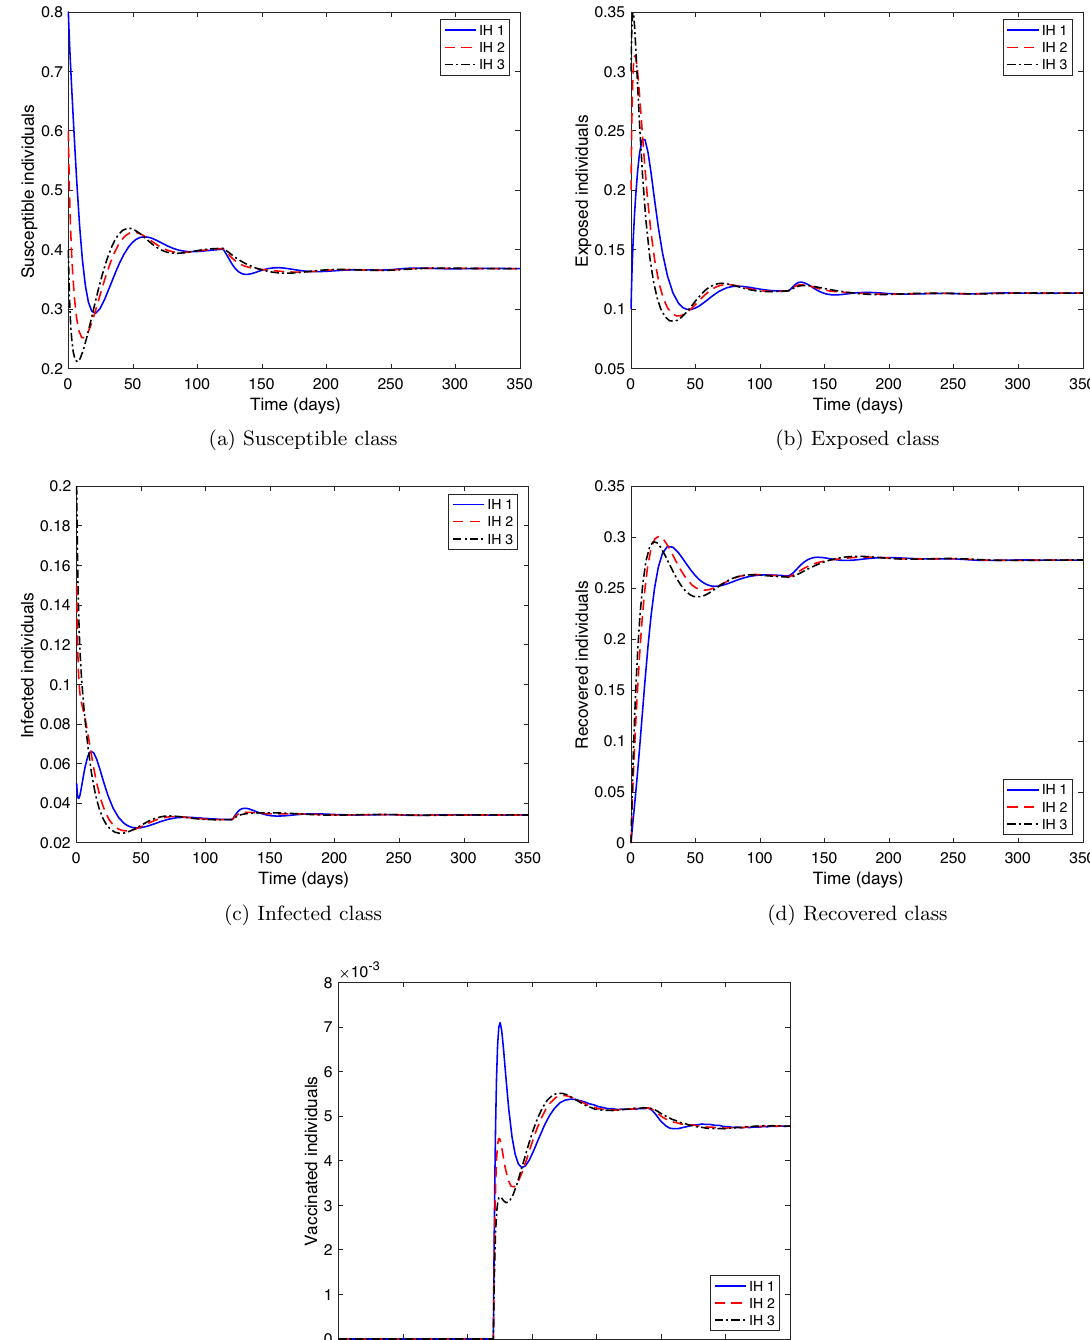
Figure 4. Numerical solution of system (25) versus time with different initial histories where R c > 1 , and stability conditions (17) and (23) are